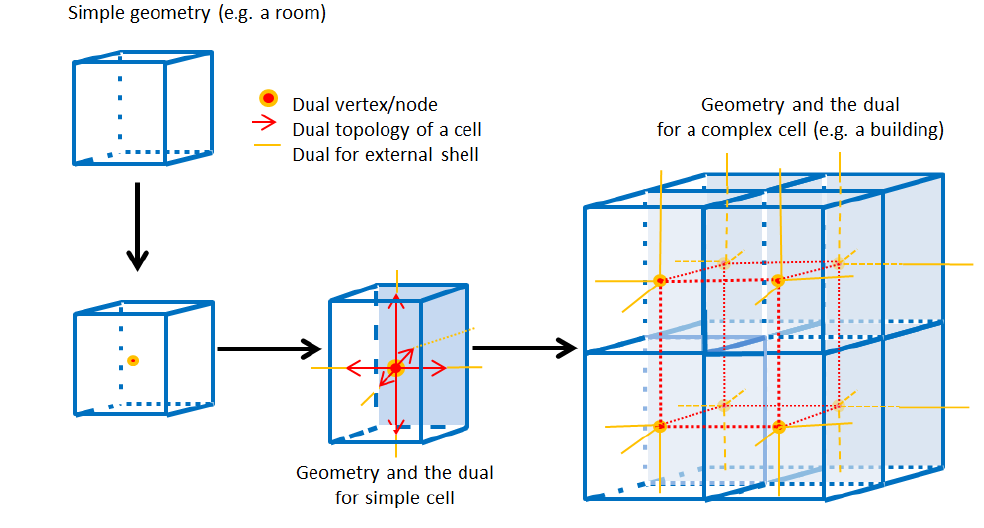
Figure 11. Poincaré duality derived concept.